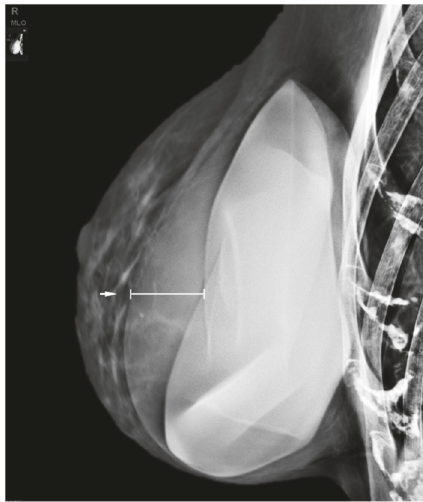
Figure 1: Mediolateral oblique view of the right breast shows a rim of density surrounding the silicone implant (white